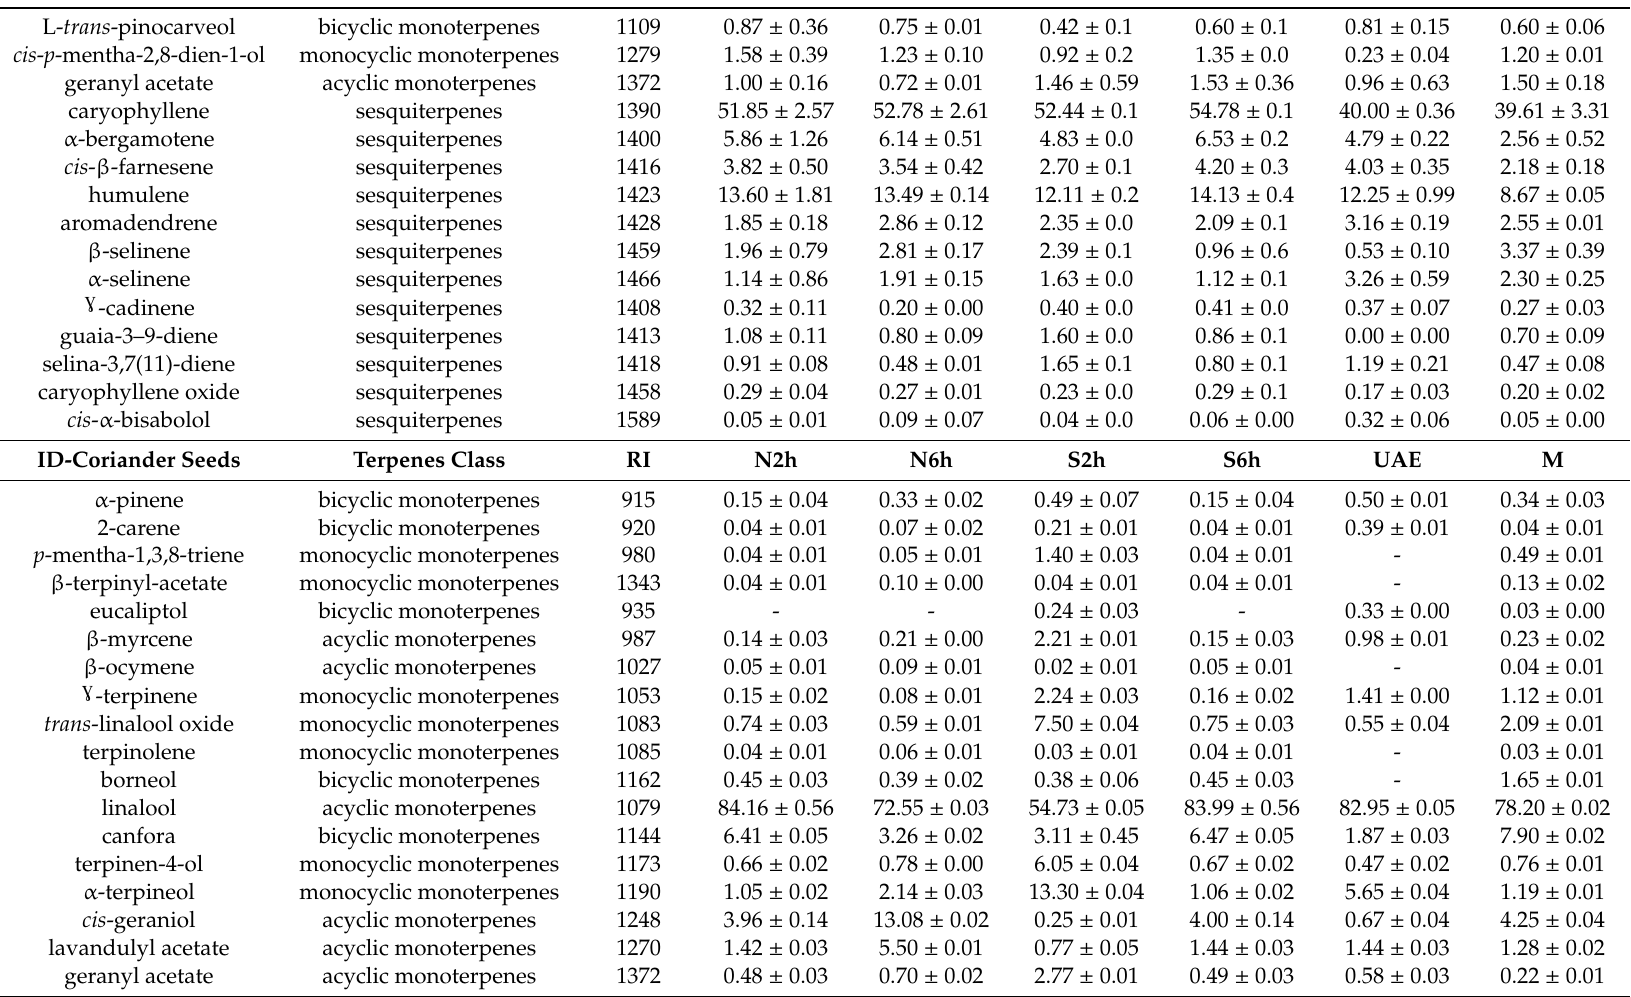
Table 2. Solid-phase microextraction/gas chromatography-mass spectrometry ( SPME/GC-MS) characterization of the volatile fraction of thyme, hemp and coriander seeds extracts. Results are expressed as relative abundances % (means ± sd).